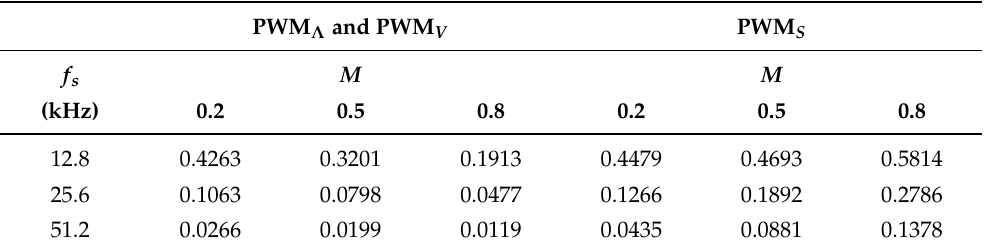
Table 2. The values of THD ∞ for a no-load open-loop PWM-controlled system as a function of M and f s